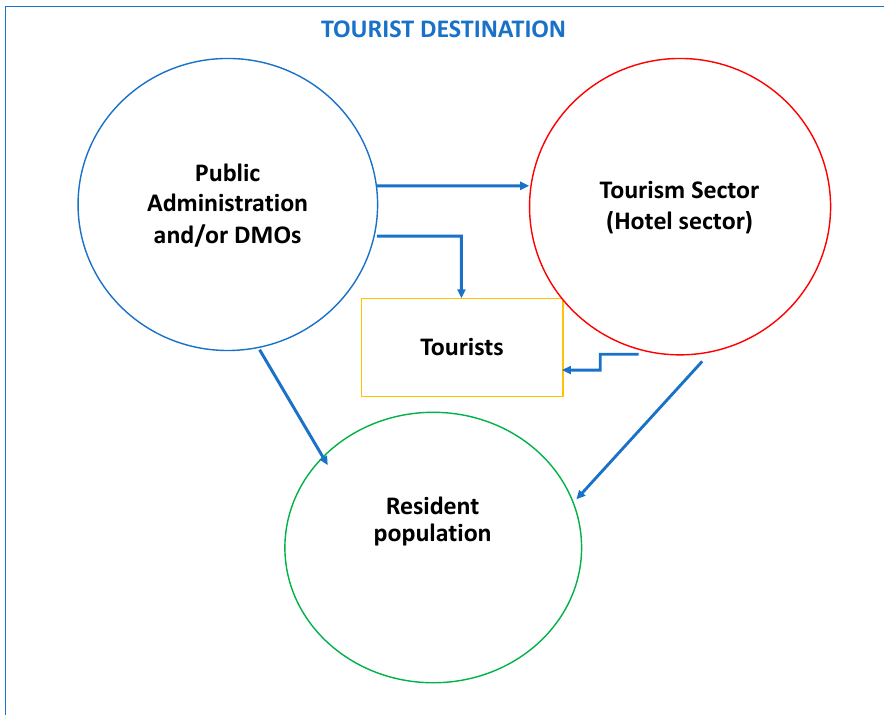
Figure 1. Three-axis model. Source: Own elaboration.